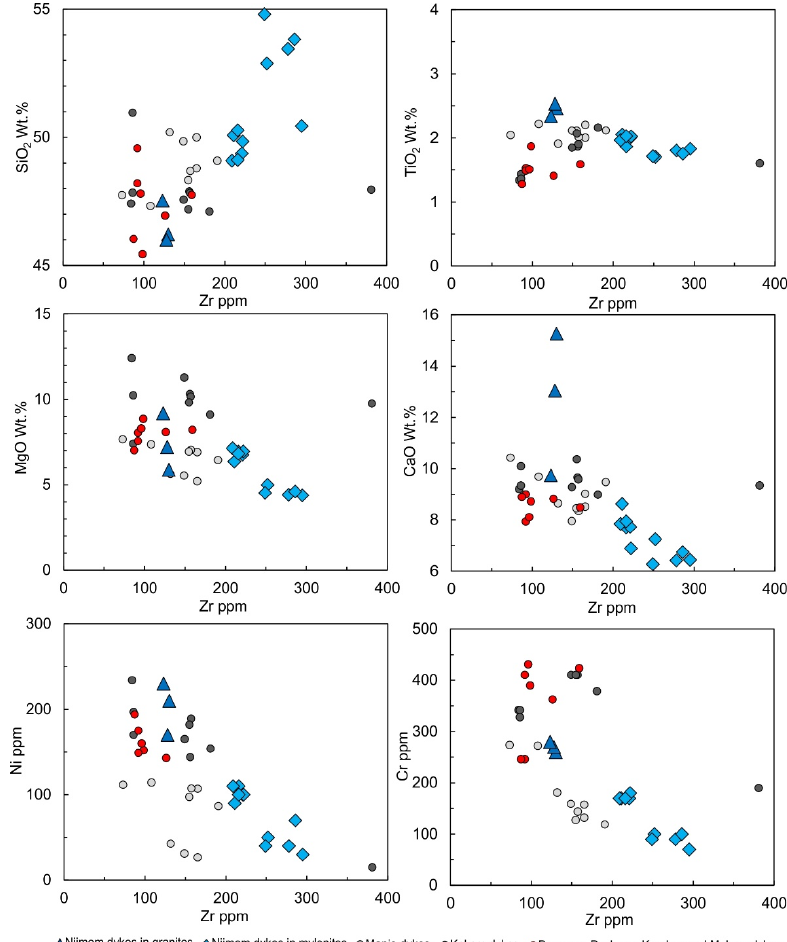
Figure 9. Zr/TiO 2 vs Nb/Y discrimination diagram [21] showing the compositions of the Njimom dykes.